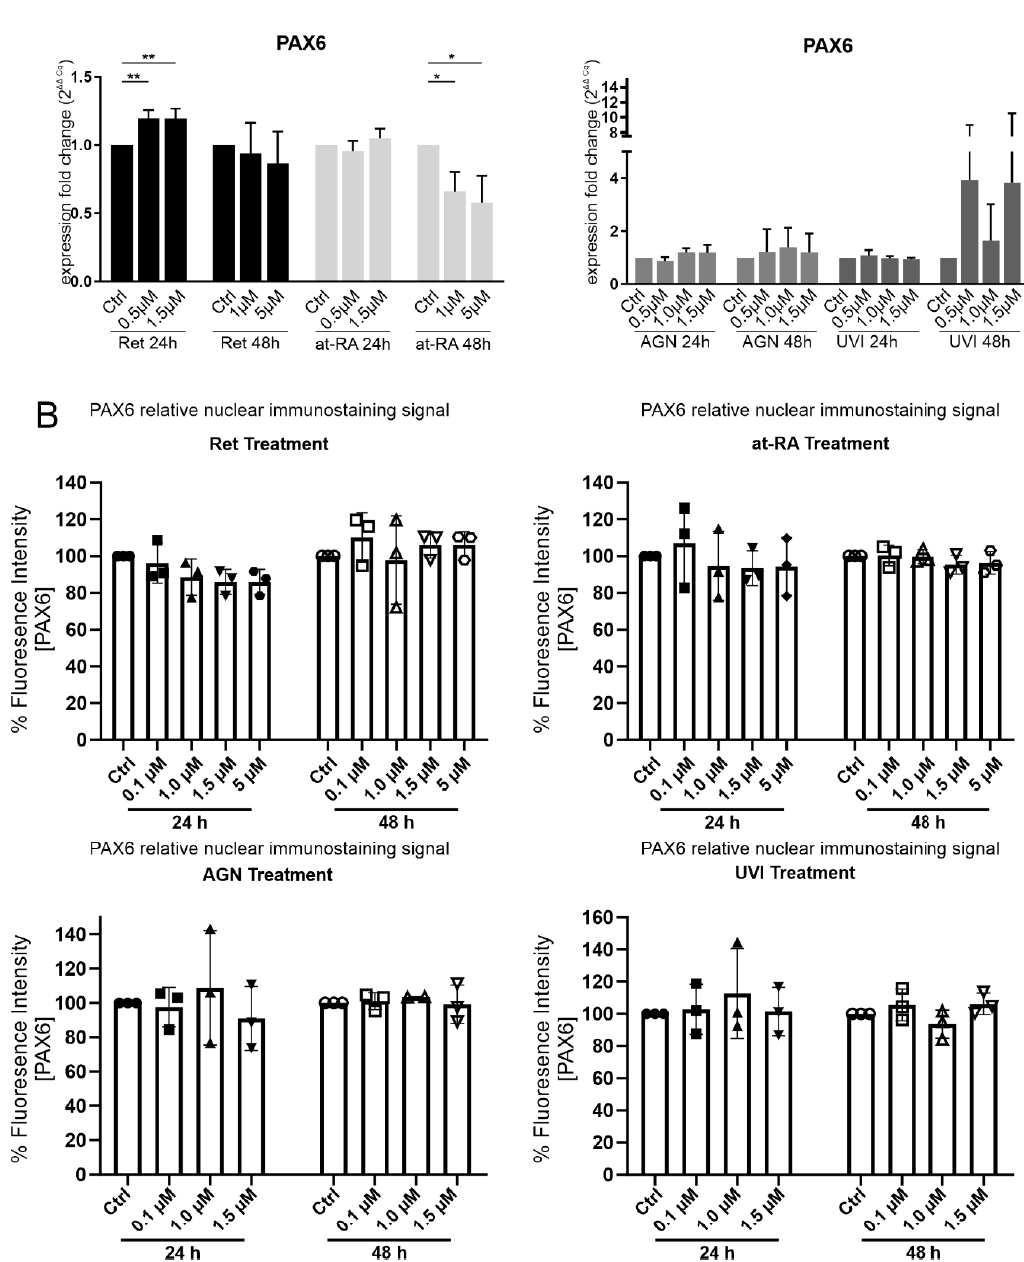
Figure 3. PAX6 mRNA ( A ) expression and PAX6-relative nuclear immunostaining signal ( B ) in primary limbal epithelial cells treated with retinol (Ret), all trans-retinoic acid (at-RA), AGN 193109 (AGN), or UVI 3003 (UVI), for 24 h and 48 h respectively. The used concentrations are indicated. ( A ) qRT-PCR analysis of PAX6 mRNA extracted from primary limbal epithelial cells (LEC). Expression fold changes (FC) are calculated relative to each control with the ∆∆ Ct method. ( B ) Nuclear PAX6 immunofluorescence staining of LEC cultures grown in 96 wells following the indicated treatment. The relative fluorescence signal of controls and treatment groups is represented as mean ± standard deviation (SD). Two images of every sample were analyzed and PAX6 nuclear intensity was normalized to control treatment of the same LEC preparation (set as 100%). * p ≤ 0.05; ** p ≤ 0.01; n =